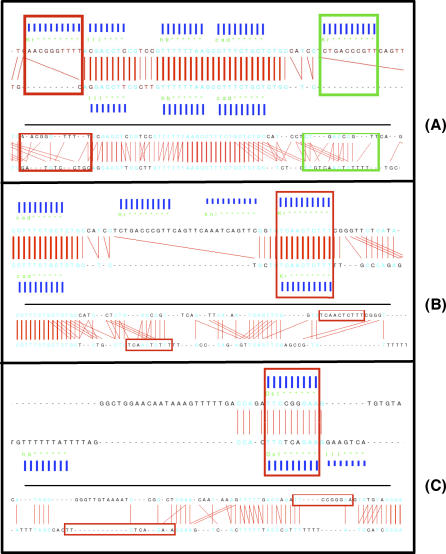
Examples of Difference in Alignments Produced by Morphalign and Its No-Motifs Version, for the hairy stripe 6 enhancerEach panel shows one example, with the Morphalign alignment at the top of that panel and the motif-agnostic alignment at the bottom. D. melanogaster is shown as the top sequence in an alignment. Vertically aligned positions are shown in blue if they are identical, in black otherwise. Red lines indicate aligned positions, with their thickness proportional to confidence (marginal probability) of that positional alignment. Only positional alignments with confidence greater than 0.1 are marked by red lines. (Note that one position may align with multiple positions in the other alignment.) Morphalign additionally shows predicted binding site locations with blue bars (whose height represents confidence level), and the motif names in green characters.(A) The red boxes show a predicted Kruppel site that is entirely unaligned by Morphalign, but is poorly and ambiguously aligned by the motif-agnostic alignment. The green box shows a similar situation.(B) A very well-aligned block with conserved Kruppel sites is found by Morphalign, but the sites are clearly separated in the motif-agnostic alignment.(C) A DStat site is aligned between the two species (by Morphalign). The no-motifs alignment conspicuously separates these potentially orthologous sites.